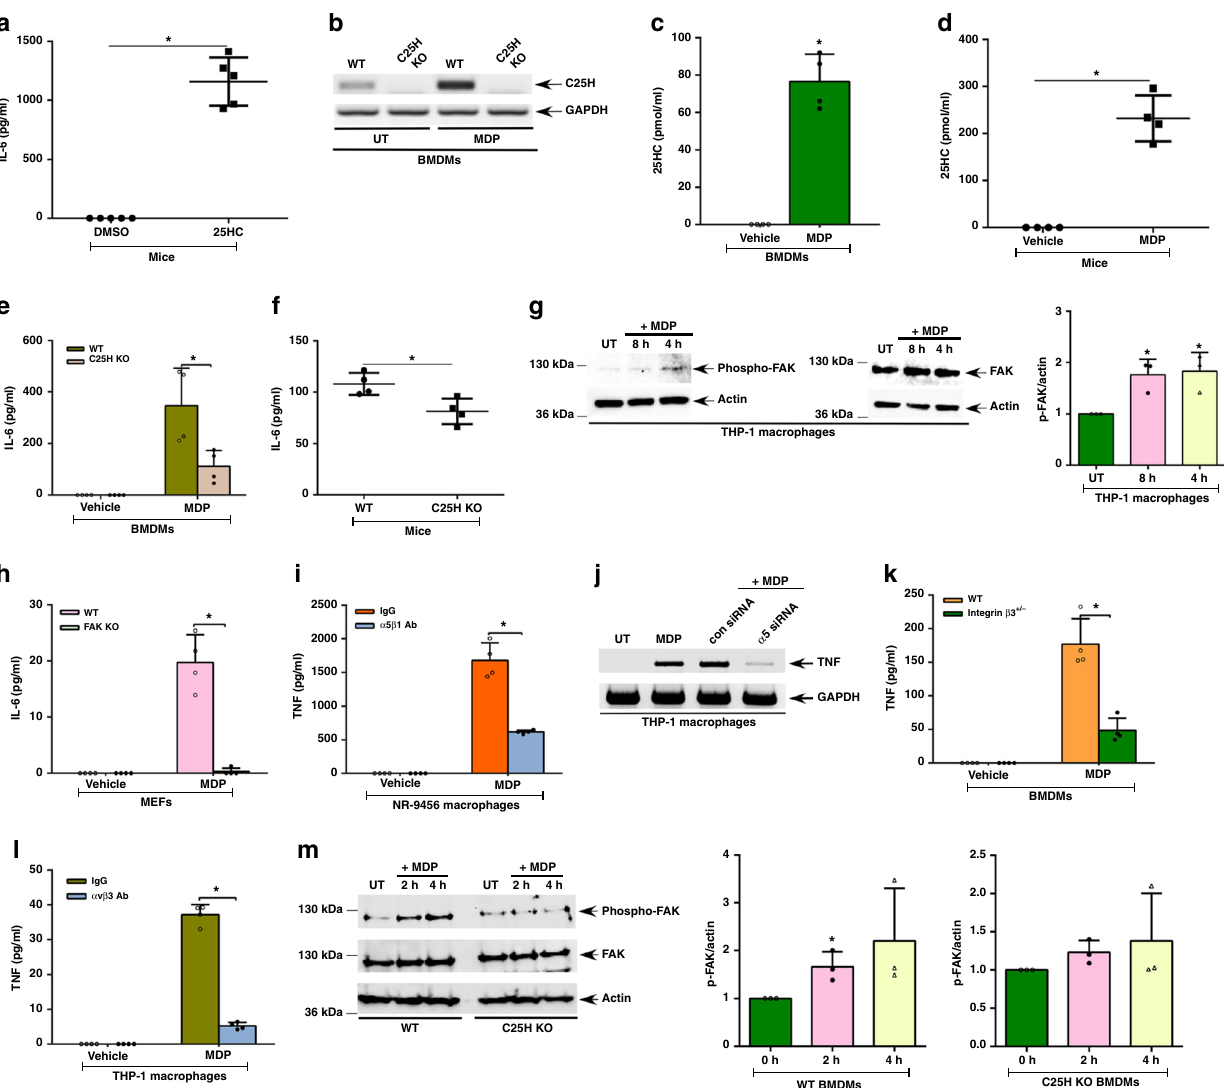
Fig. 6 The 25HC-integrin-FAK signaling network is required for optimal Nod2 response. a IL-6 in serum of mice injected (via intraperitoneal route) with 25HC (50 mg/kg; 4 h) ( n = 5). b , c , e , g – m Cells were treated with 25 µ g/ml of MDP for 8 h and d , f mice were injected intraperitoneally with 20 mg/kg of MDP for 4 h. C25H expression, 25HC production, FAK activation, and proin fl ammatory response were assessed. b RT-PCR analyses of C25H expression in MDP-treated wild-type (WT) and C25H knockout (KO) BMDMs. c 25HC levels in the medium supernatant of MDP-treated BMDMs. d 25HC levels in the serum of WT mice treated with MDP ( n = 4). e IL-6 secretion from WT and C25H KO BMDMs treated with MDP. f IL-6 levels in the serum of WT and C25H KO mice treated with MDP ( n = 4). g Western blot and densitometric analyses of FAK activation (phospho-FAK, Tyr397) status in MDP-treated THP-1 macrophages. h IL-6 production from MDP-treated WT and FAK KO MEFs (mouse embryo fi broblasts). i IL-6 secretion from MDP-treated NR-9456 macrophages in the presence of either control IgG or α 5 β 1 integrin blocking antibody (Ab). j RT-PCR analyses of TNF expression in MDP-treated THP- 1 cells transfected with either control siRNA (con siRNA) or α 5 integrin-speci fi c siRNA ( α 5 siRNA). k TNF secretion from MDP-treated WT and β 3 integrin- de fi cient ( β 3 + / − cells) BMDMs. l TNF secretion from MDP-treated THP-1 macrophages in the presence of either control IgG or α v β 3 integrin blocking antibody. m Western blot and densitometric analyses of FAK activation (phospho-FAK, Tyr925) status in MDP-treated WT and C25H KO BMDM. RT-PCR